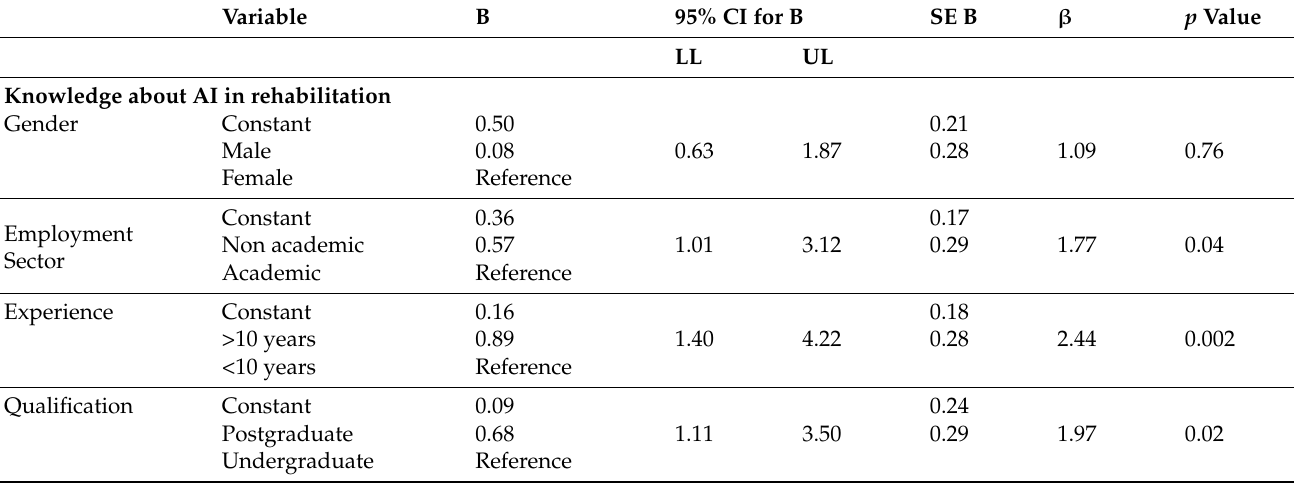
Table 2. Logistic regression to assess the factors associated with